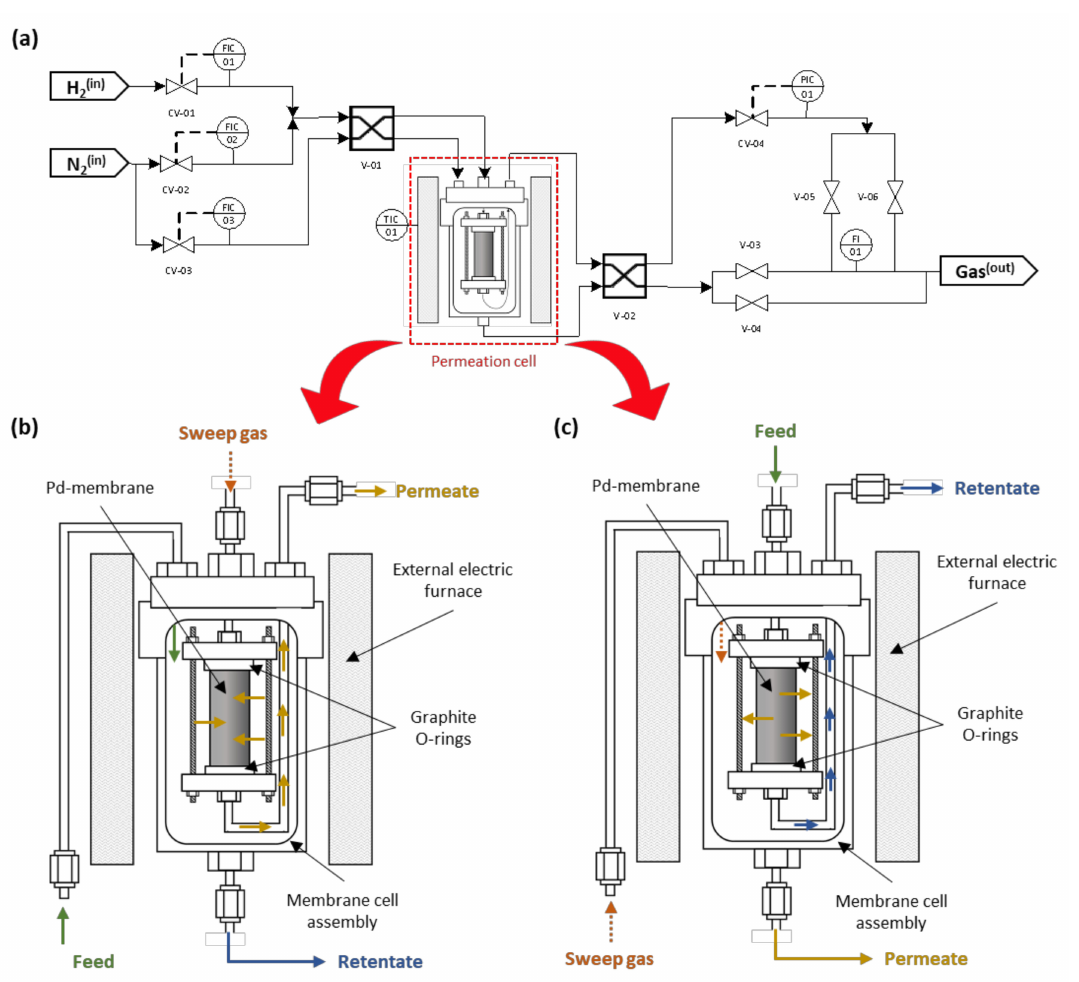
Figure 1. Basic scheme of the permeation setup ( a ) and possible configurations for permeation experiments: mode out–in ( b ) and mode in–out ( c